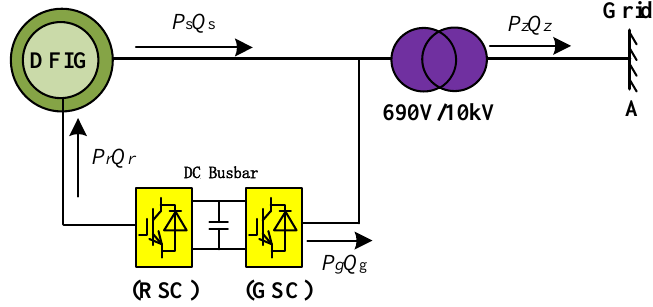
Figure 1. Schematic diagram of DFIG power flow direction.